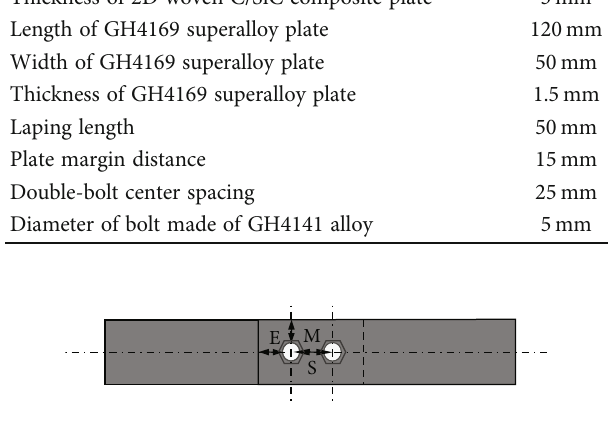
Figure 2: Schematic diagram of the geometry parameters of the studied double bolted joints for the parametric